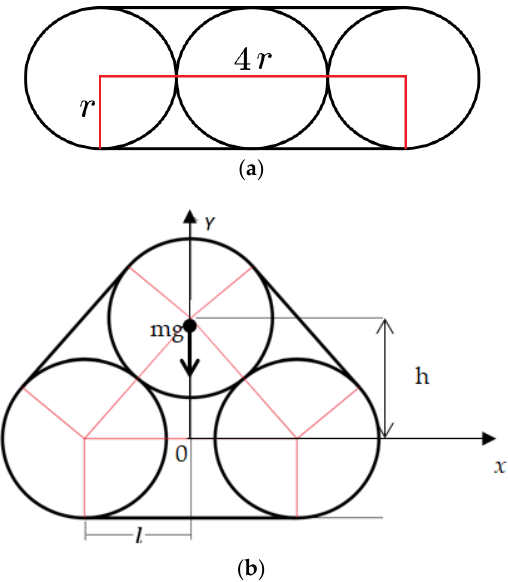
Figure 1. Calculation scheme of the pendulum (excluding friction forces). ( a , b ) has been explained in the paragraph above.